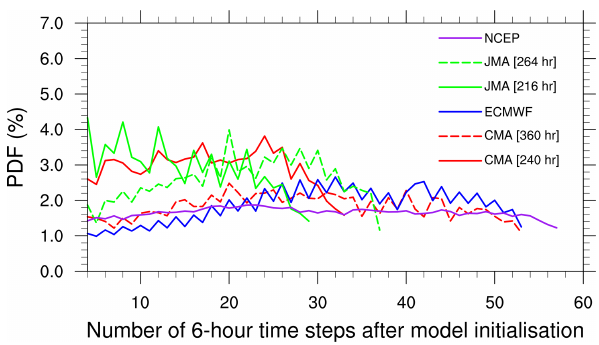
Figure 6. Temporal evolution of frequency of first storm detections of the TPEPS event set (CMA: red, ECMWF: blue, JMA: green, NCEP: purple).